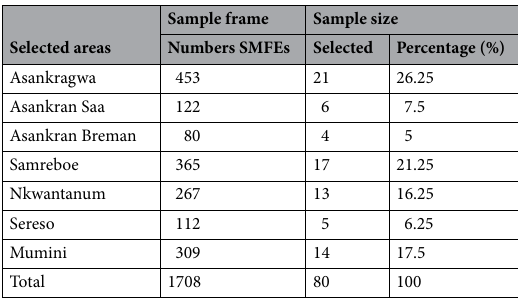
Table 1. Sample Size Distribution of SMFEs by Location.